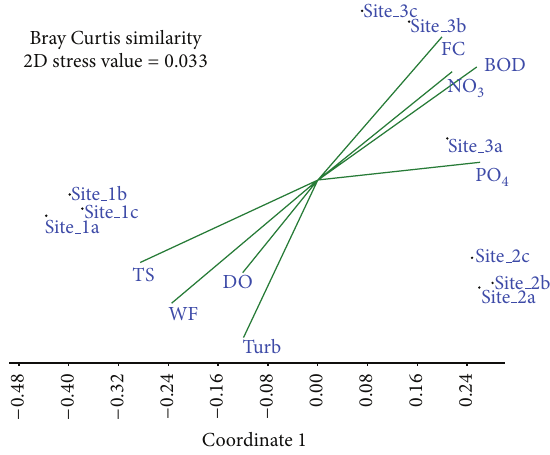
Figure 2: Nonmetric multidimensional scaling (nMDS) plot; pat- tern of the benthic community structure based on the species abundances and physicochemical parameters (a, b, and c case letters after site number show stations of each site).